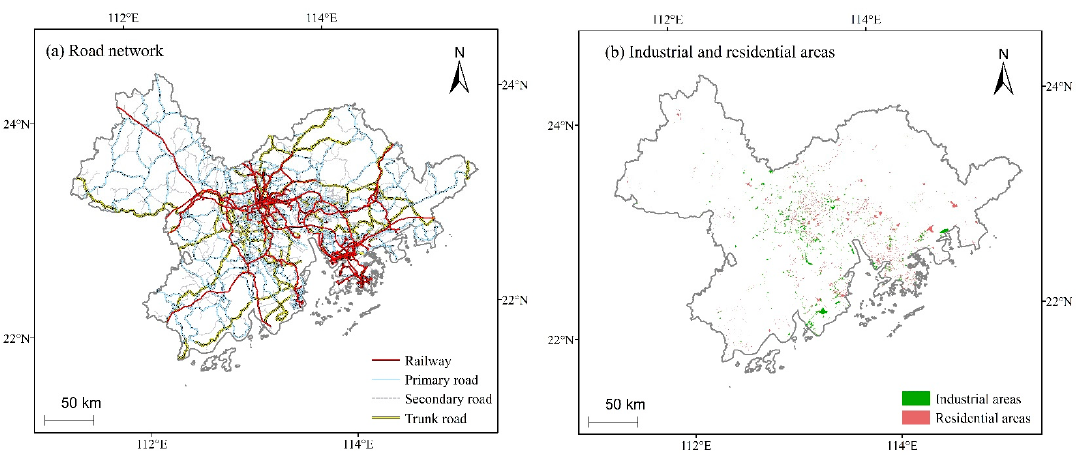
Figure 3. Data used in this study showing ( a ) the road network, and ( b ) industrial and residential areas in the GBA. Socioeconomic data included population distribution (POP) data and gross domestic product (GDP) data. Population data for the years 2000–2015 were derived from Oak Ridge National Laboratory (ORNL) LandScan global population distribution data at approxi- mately 1 km (30 (cid:48)(cid:48) × 30 (cid:48)(cid:48) ) spatial resolution